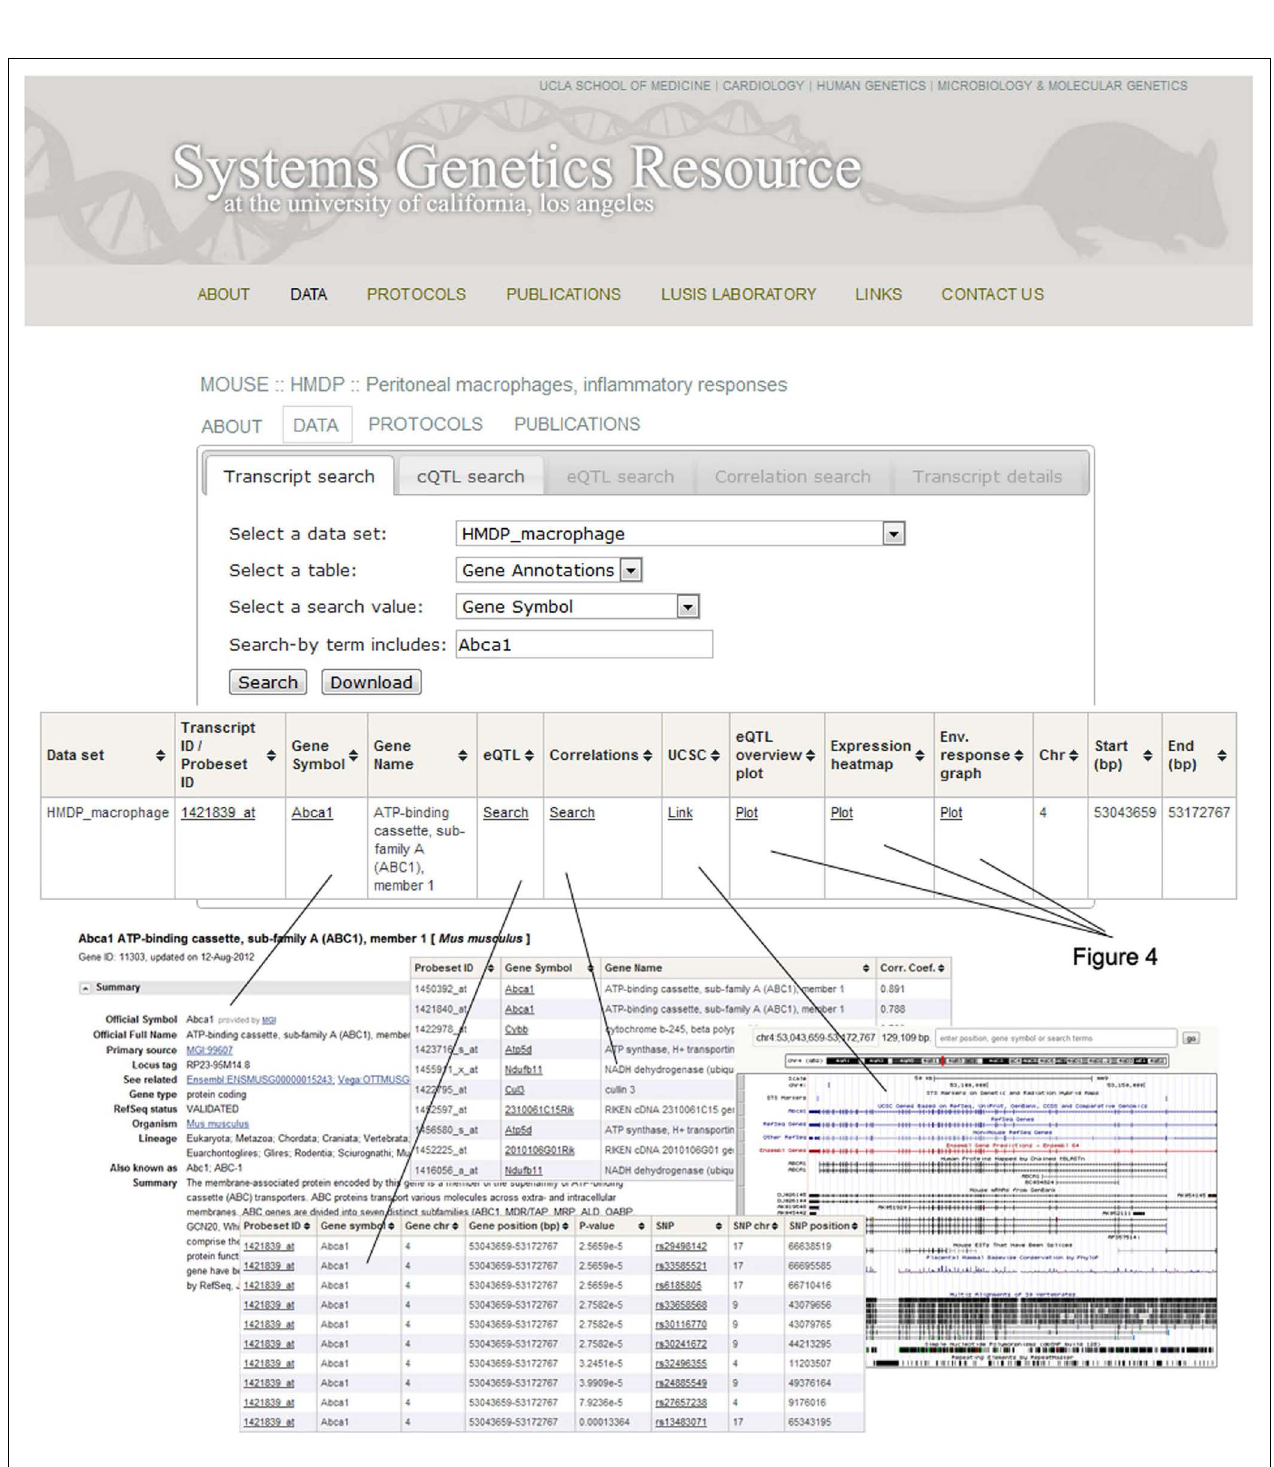
location.The “correlations” tab produces a list of genes correlated with Abca1, including their gene symbol and the correlation coefficient.The “eQTL” tab provides a list of Abca1 eQTLs, including both detailed transcript and SNP information. Lastly, eQTL localizations, gene expression levels, and treatment response values are graphed by clicking on the “eQTL overview plot,” “Expression heatmap,” and “Environmental response graph” links,